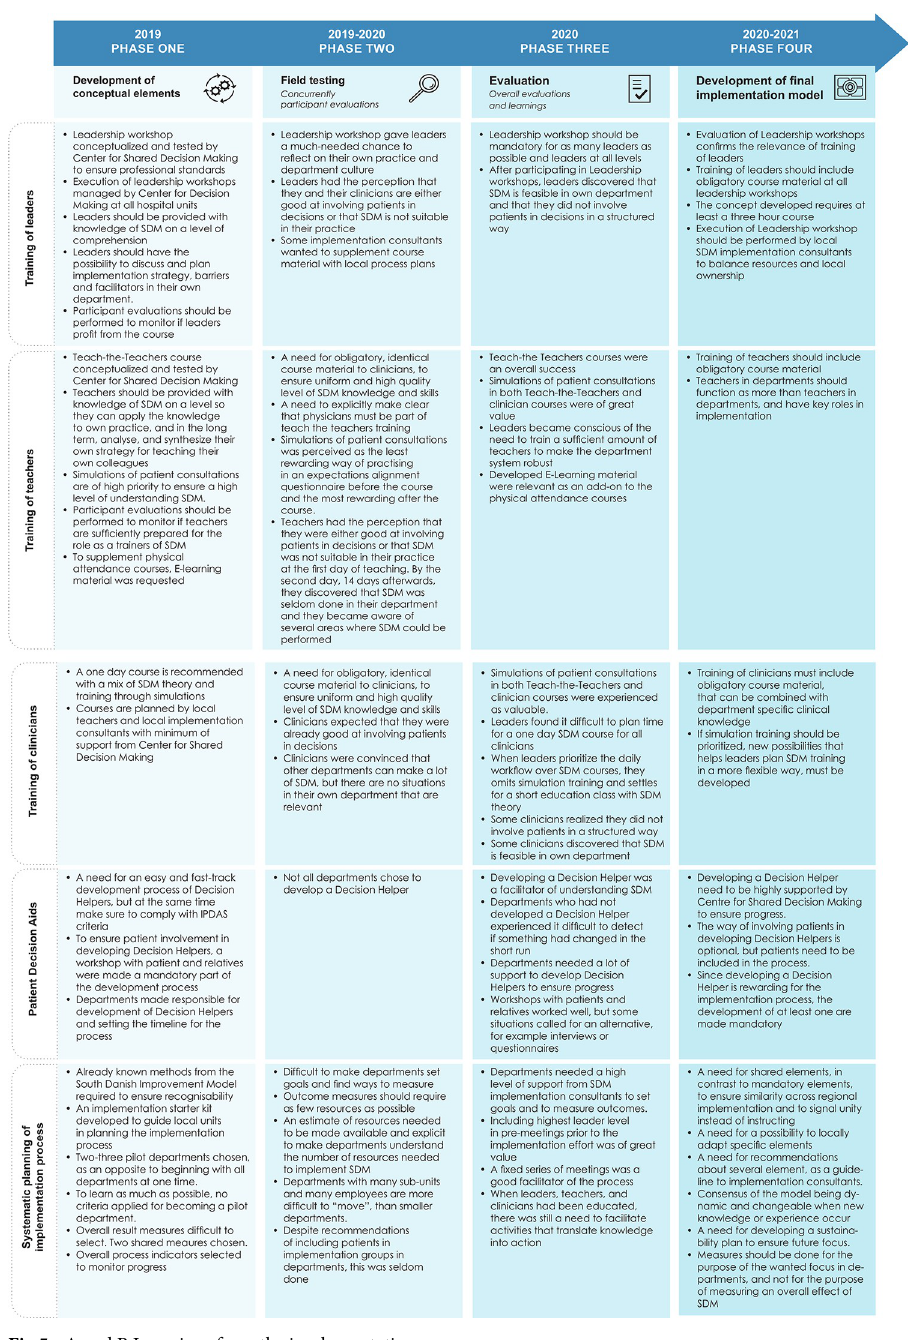
Fig 5. A and B Learnings from the implementation